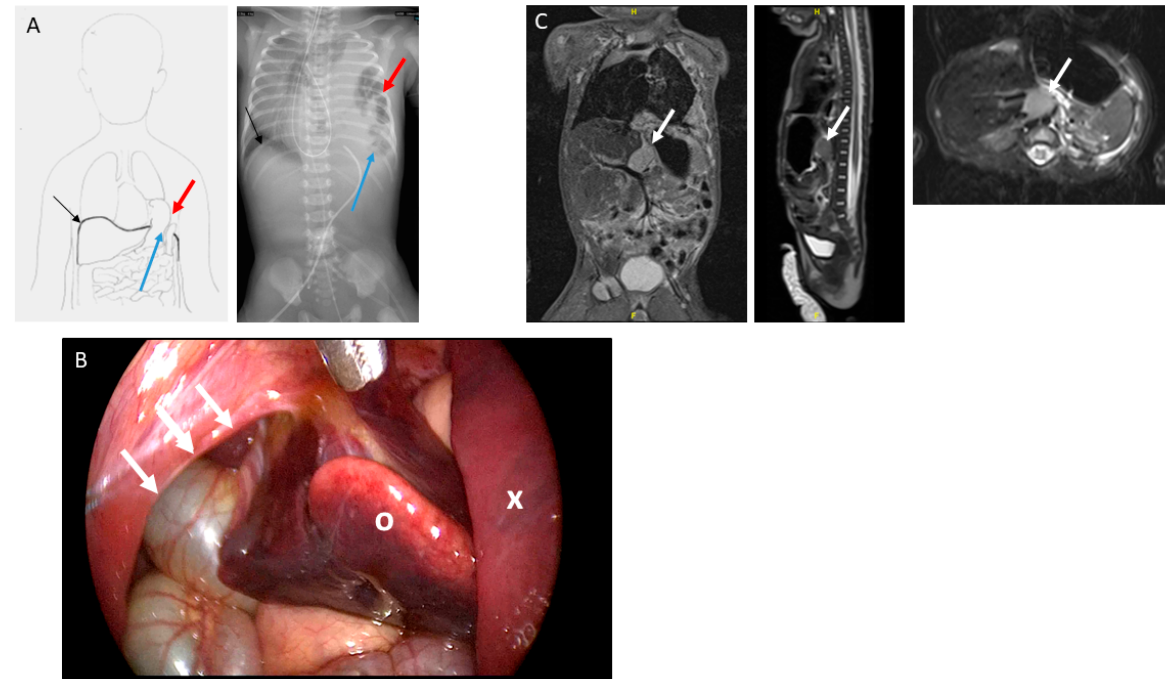
Figure 1. Diagnosis of congenital diaphragmatic hernia (CDH) and neuroblastoma. Intraoperative situs at hernia repair. ( A ) Anatomical conditions in the patient regarding the congenital diaphragmatic hernia schematically (left panel) and on patient X-ray (right panel). Black arrow—regular right-sided diaphragm; blue arrow—left-sided diaphragmatic defect; red arrow—intrathoracic intestine. ( B ) The intraoperative situs at time of hernia repair in shown case. The edge of the diaphragm is marked by white arrows, the left lung is indicated by x and the metastatic liver segment reaching through the diaphragmatic defect by O. ( C ) Magnetic resonance imaging (MRI) shows the neuroblastoma retroperitoneally behind the liver and stomach in front of the abdominal aorta and inferior vena cava (left panel—coronal view; middle panel—sagittal view; right panel—transversal view). Close proximity is given to the liver and the great vessels. In each panel, the primary tumor is indicated by an arrow. MRI was performed after hernia repair.